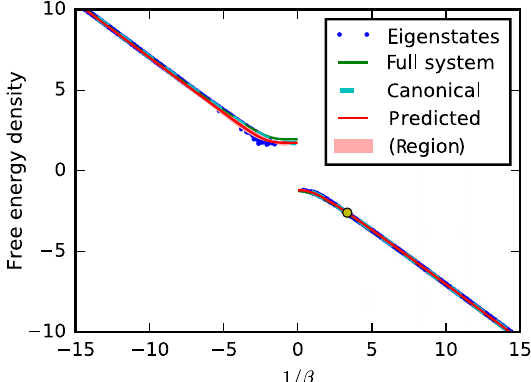
FIG. 16. Free energy density as a function of temperature for system size L ¼ 21 . The green curve is the free energy density for the entire system in the canonical ensemble, given by ½h H i − S th = β (cid:2) =L . The remaining curves each plot the free energy 4 subsystem (i.e., ½h H − S ð ρ = β (cid:2) =L density within the L ), A ¼ A i A Þ A with respect to some reduced density matrix ρ in subregion A : A The blue dots consider each energy eigenstate, the dashed cyan curve represents the canonical ensemble, and the red curve contains the values predicted from a single eigenstate at β 0 ¼ 0 . 3 (itself shown in yellow). As in Fig. 15, the “ predicted ” density matrix is obtained by raising the eigenstate ’ s reduced density matrix to the power β = β 0 and rescaling it to have unit trace. In fact, the eigenstate at β 0 ¼ 0 . 3 is not unique: The independent predictions from each of the 214608 eigenstates in the range 0 . 2 < β 0 . 5 all fall within the region shaded in 0 <